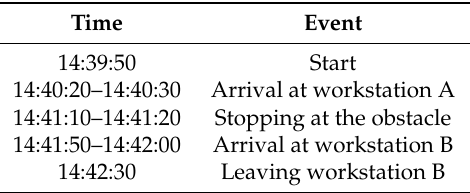
Table 1. Schedule of Test